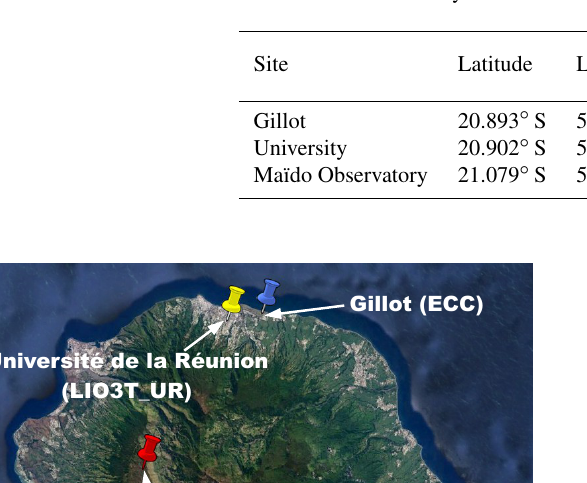
Table 1. Coordinates and distance to Maïdo Observatory from the observation sites used in this study.